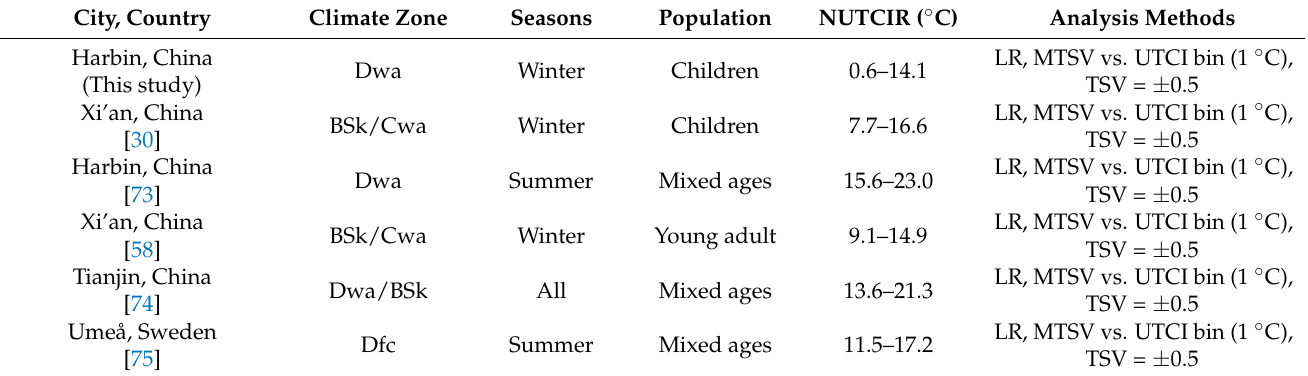
Table 11. Neutral UTCI range in different OTC